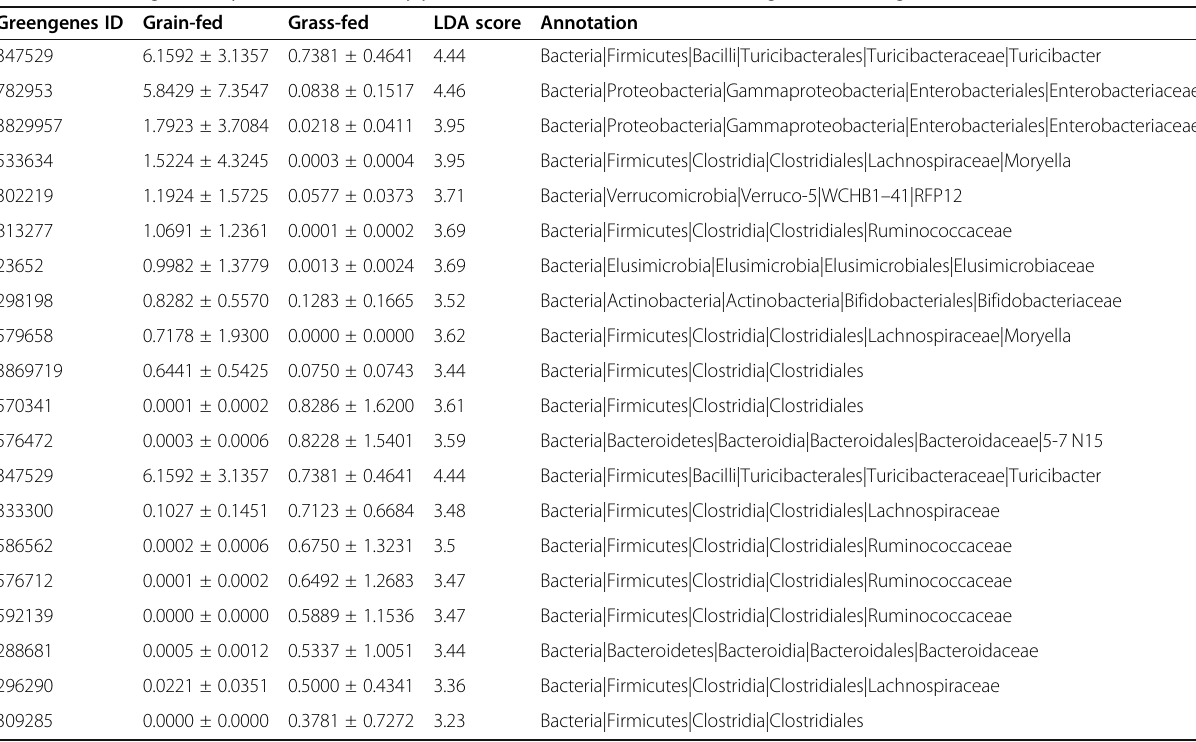
Table 2 Select significantly different OTUs in jejunal bacterial communities between grain-fed and grass-fed cattle Greengenes ID Grain-fed